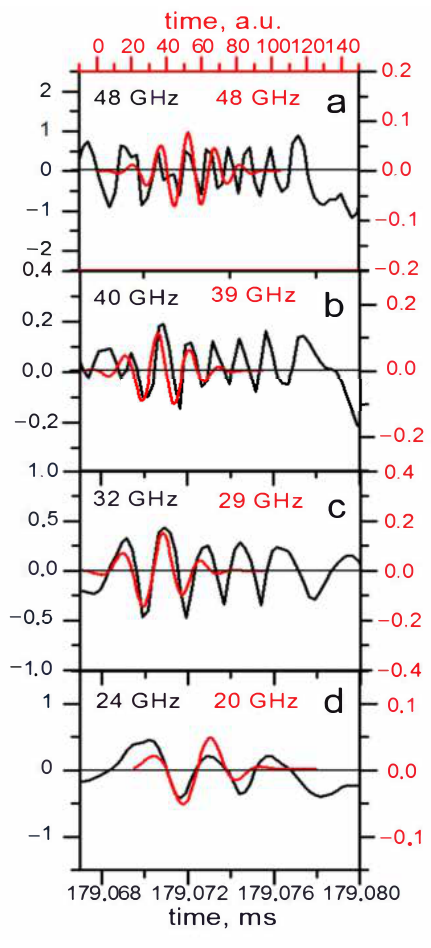
Figure 22. Experimental DBS signals (black lines) and calculated DBS signals for a strip filament model (red lines) for different probing frequencies.